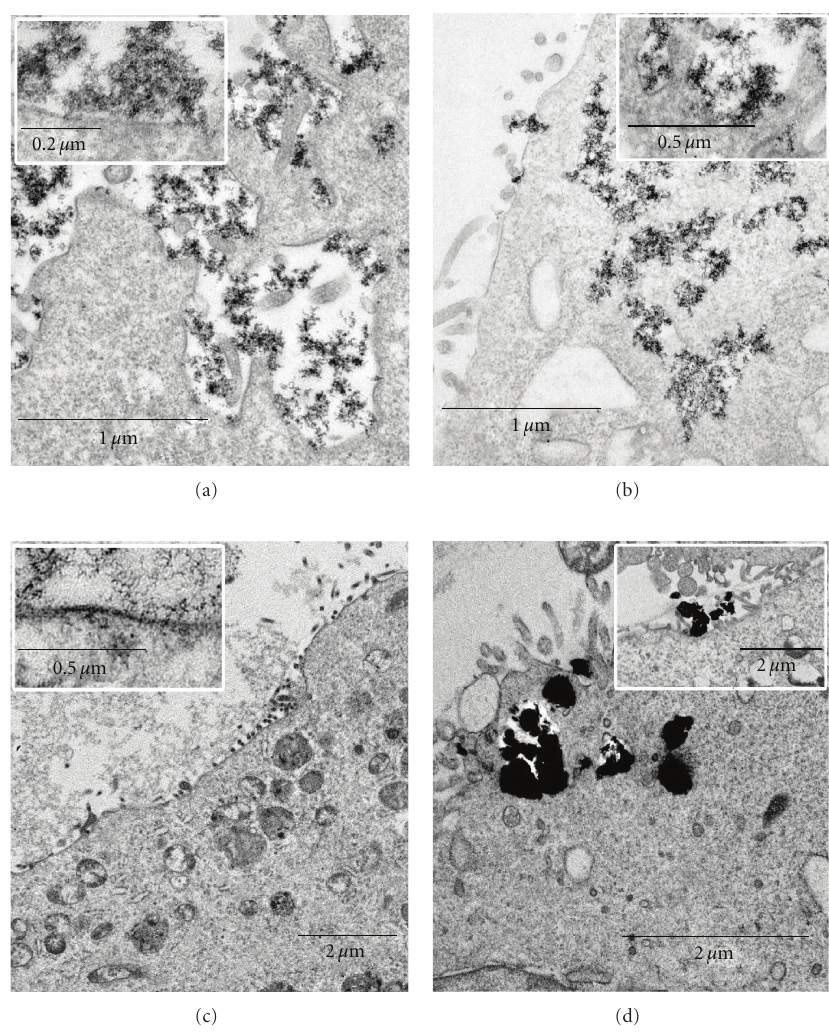
Figure 10: Interaction of MDCK cells with TiO 2 nanoparticles: amorphous (a), anatase (b), brookite (c), and rutile (d). Inserts show direct contact of the nanoparticles with cell plasma membrane. Ultrathin sections. Transmission electron